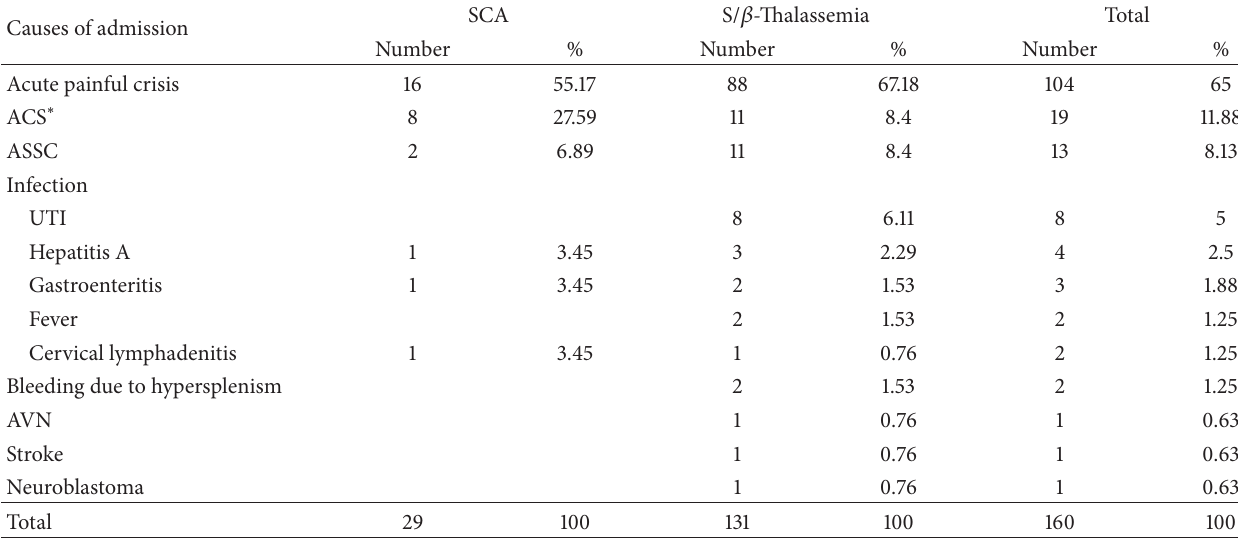
Table 3: Causes of admission in relation to type of SCD.